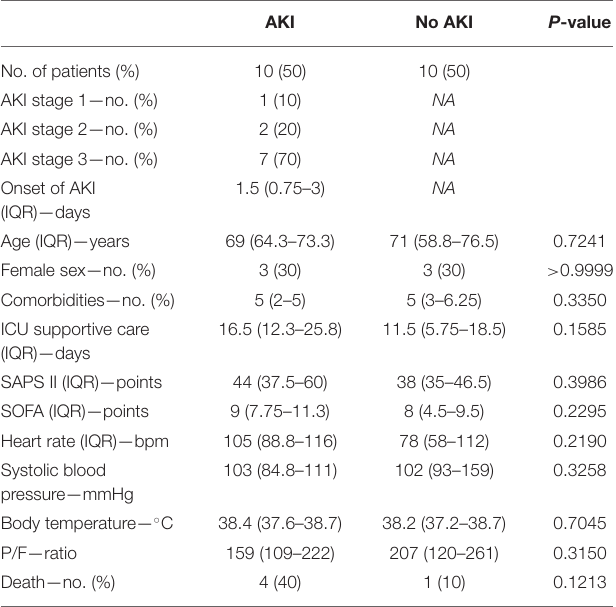
TABLE 1 | Association between AKI in COVID-19 and clinical